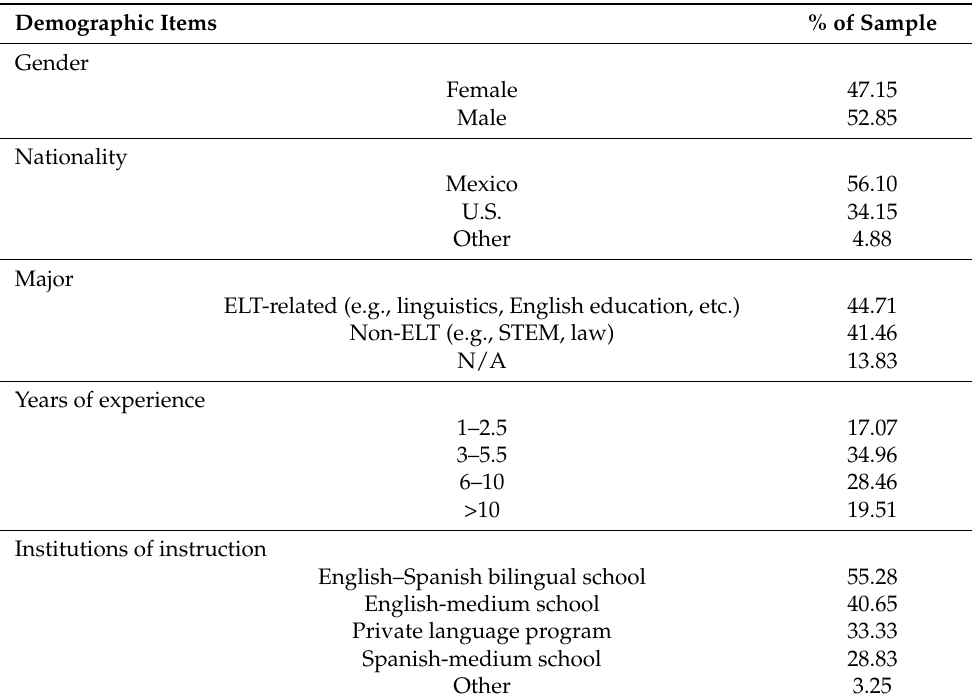
Table 1. Participant profile (N =